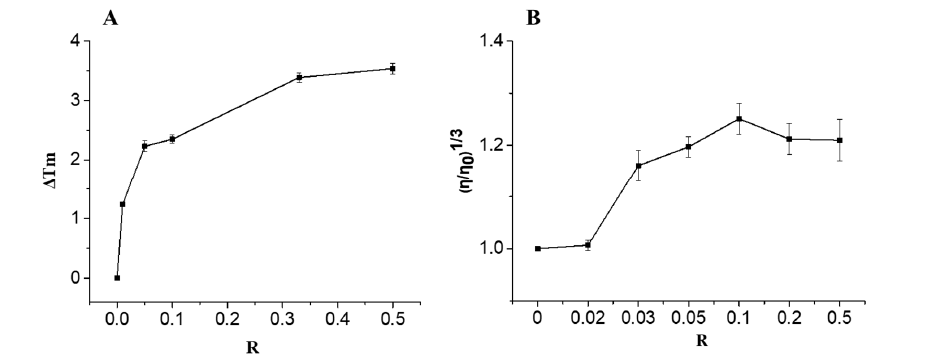
Figure 2. Thermal denaturation data of CT ‐ DNA ( A ) and Effect of increasing amounts on the relative viscosity of CT ‐ DNA ( B ) upon addition of compound 6 with ratios R = [compound 6 ]/[DNA] ranging from 0 to